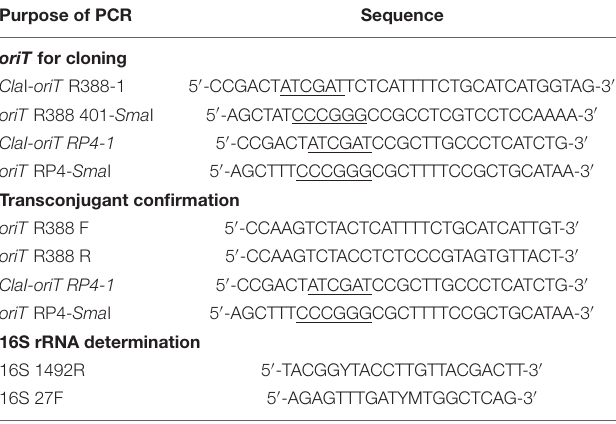
TABLE 3 | Primers used for